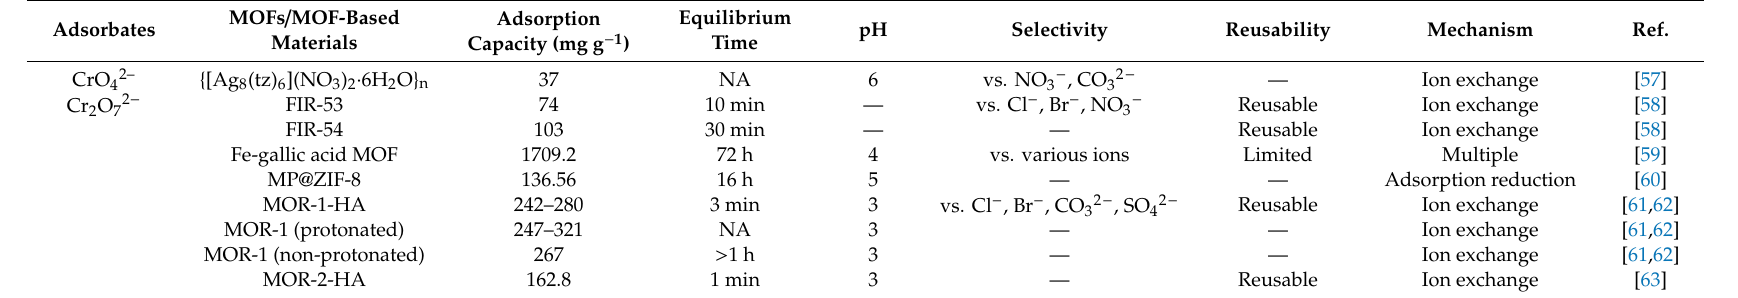
Table 2. Chromium adsorption data for the reported MOFs and MOF-based